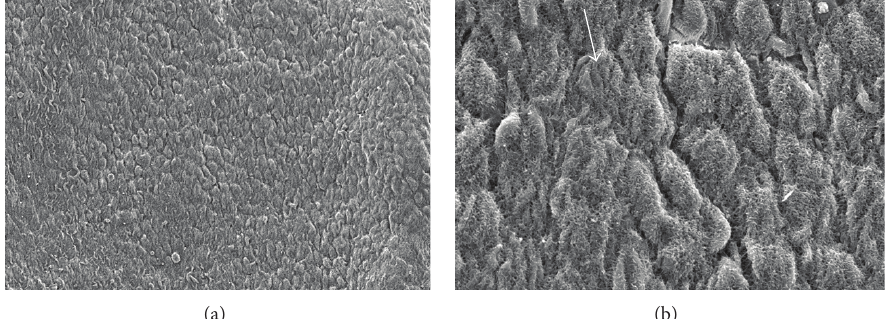
Figure 4: Mesothelial surface from rats 12h after insufflation with warm, dry CO 2 for 2h at 5mm/Hg (group 3). Mesothelial cells are rounded and show distinct indentations (crenation) to the exposed surface (arrow): (a) original × 650; (b) original ×